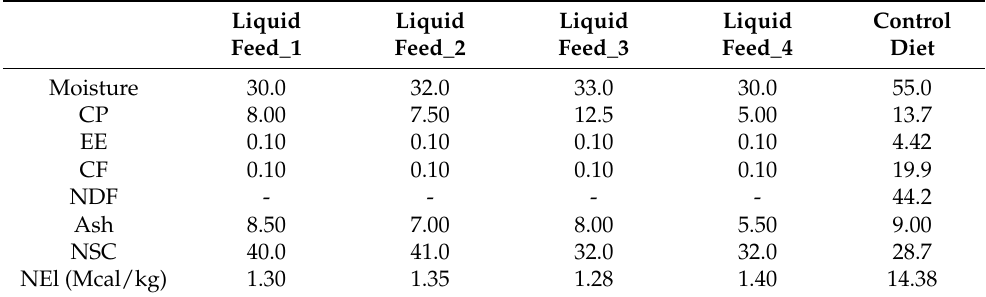
Table 2. Chemical composition (% as feed) of the tested liquid feeds (Sugar Plus ® ) and control TMR